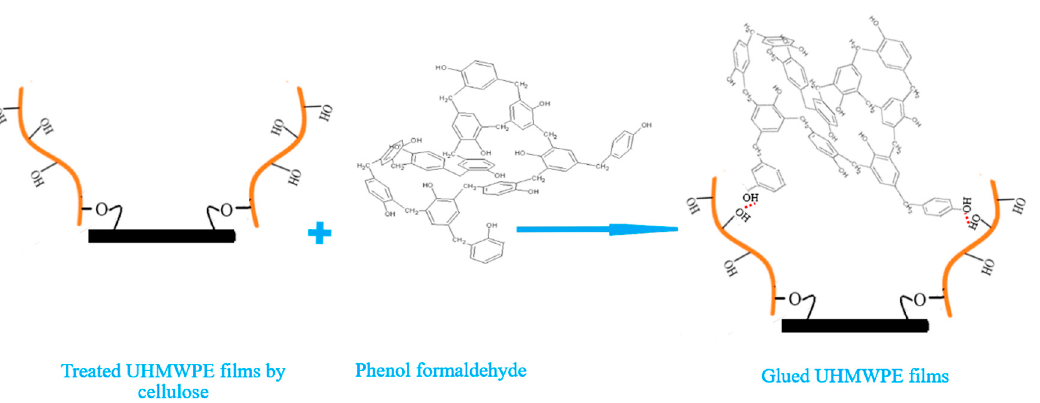
Figure 4. Hydrogen bonds between cellulose and phenol formaldehyde.